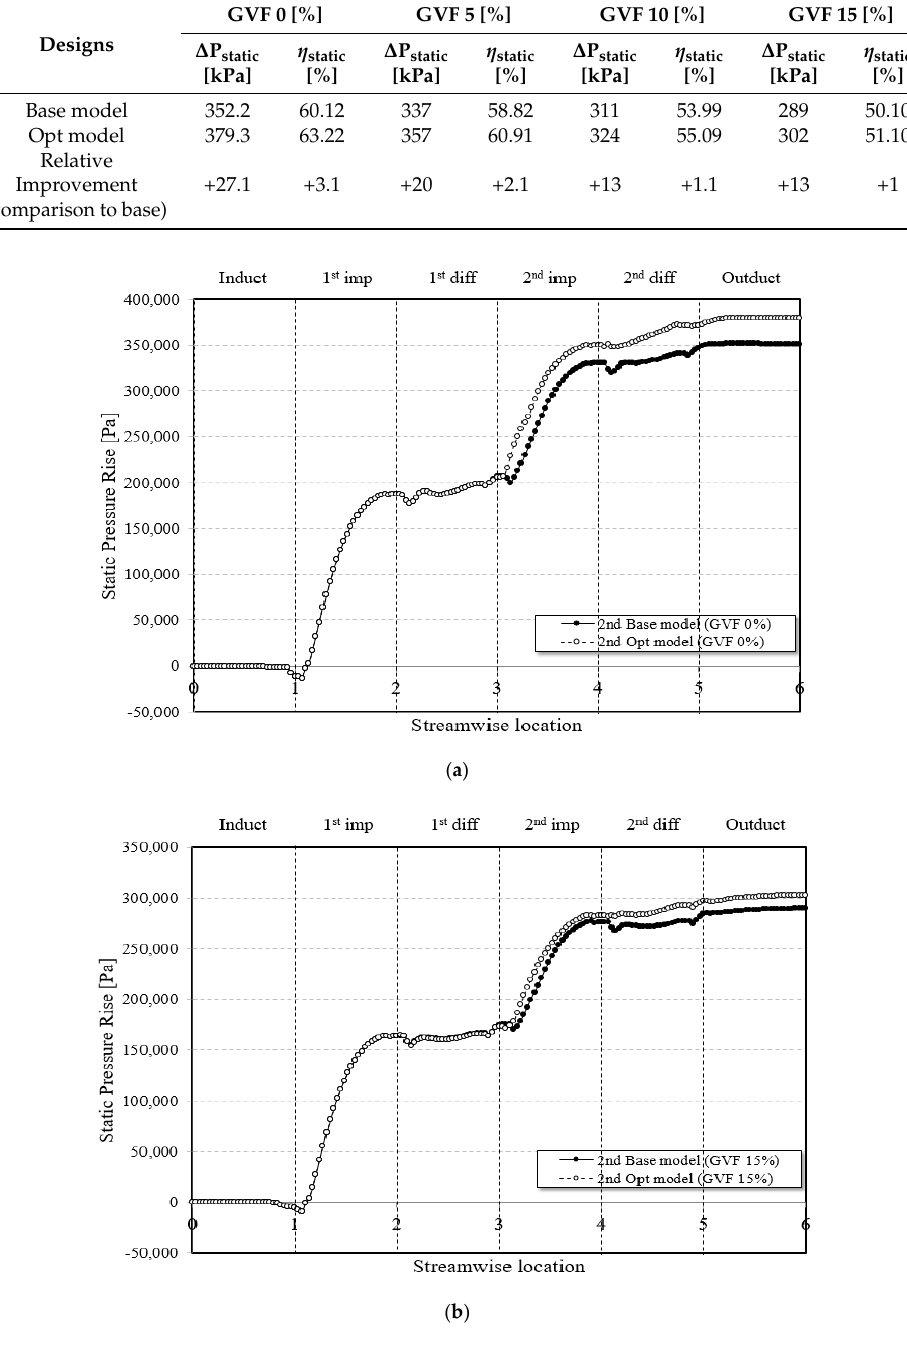
Figure 11. Distributions of static pressure at 50% span along the streamwise location. ( a ) Gas Volume Fraction 0%; ( b ) Gas Volume Fraction 15%.